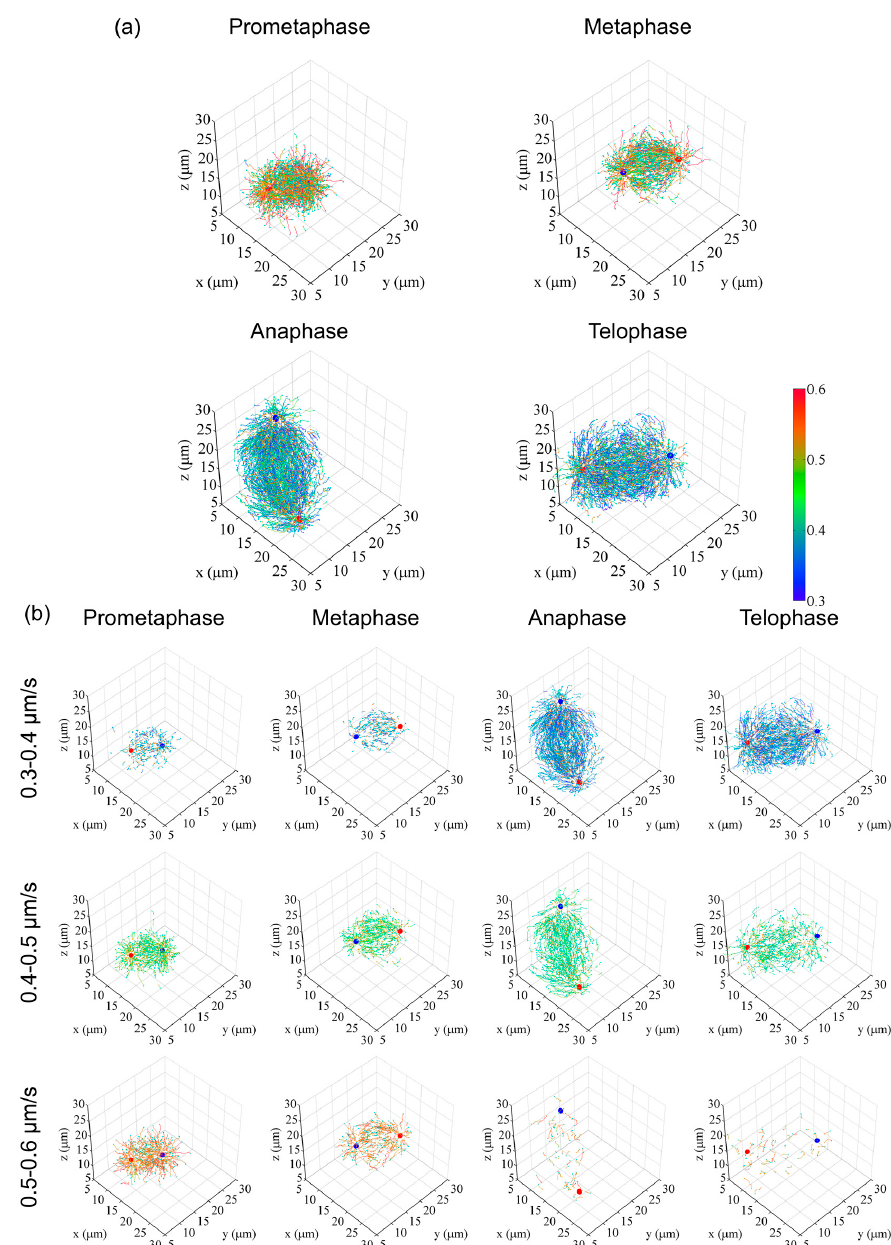
Figure 4. Examples of digital spindle analysis. ( a ) Digitized and 3D-represented microtubule growth trajectories in various mitotic phases, represented using custom tools created in Matlab. For original images and EB1–GFP tracking to generate trajectories, see also Video S2. Three cell data (prometa, meta, ana) and two cell data (telo) were merged to generate average models. To improve visibility, trajectories were randomly extracted at approximately 13% per cell (prometa, meta, ana) or 20% per cell (telo). Red and blue dots indicate centrosome position. Orange and cyan dots indicate the start and end position of trajectories, respectively. The colored bar indicates the range of the mean travel speed of EB1–GFP comet trajectories (0.3–0.6 μ m/s). ( b ) Merged trajectories were divided into 10 classes spanning the entire speed data range (0–1 μ m/s, 0.1 μ m/s steps). Data included in the 0.3–0.6 μ m/s range are shown. Markers are similar to those in (a). Data are reused from [12].